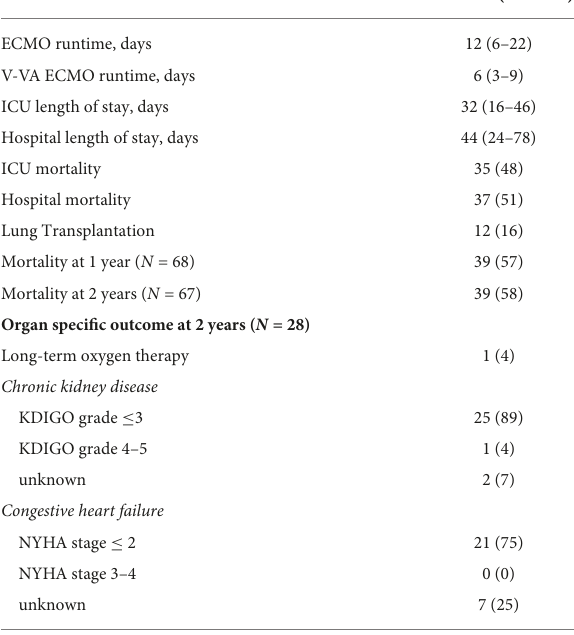
TABLE 4 Outcome and